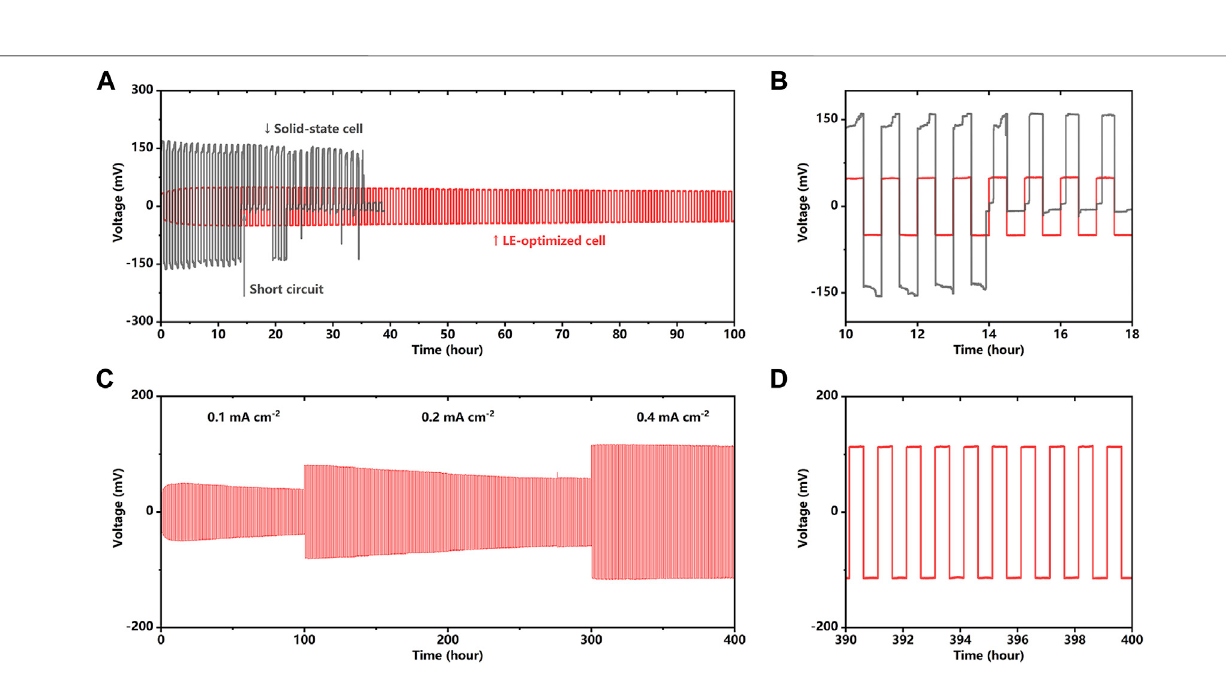
FIGURE 2 | (A,B) Galvanostatic cycling of Li/Li 2 OHCl/Li cell with and without LE optimization at a current density of 0.1 mA cm LE-optimized Li/Li 2 OHCl/Li cell at current densities of 0.1 mA cm − 2 (100 h), 0.2 mA cm − 2 (200 h), and 0.4 mA cm − 2 (100 h).